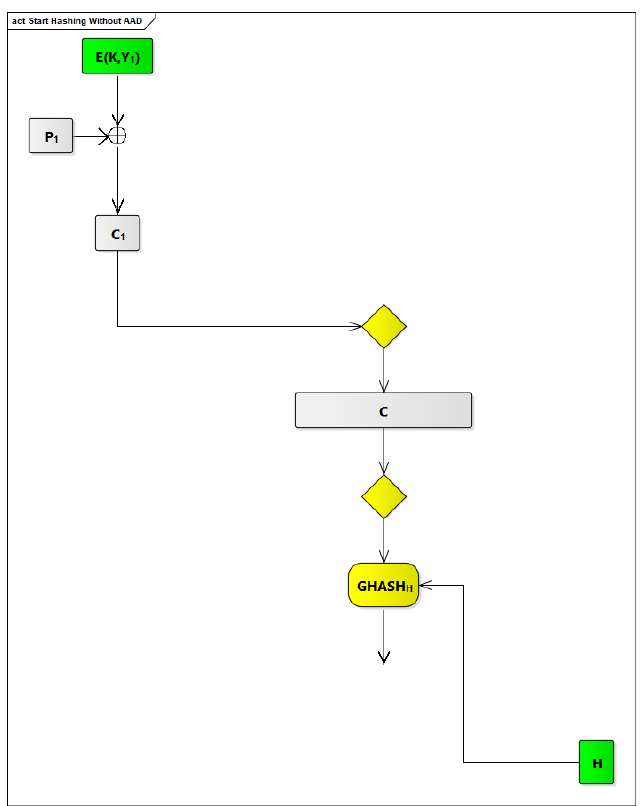
Figure 11. Start hashing without